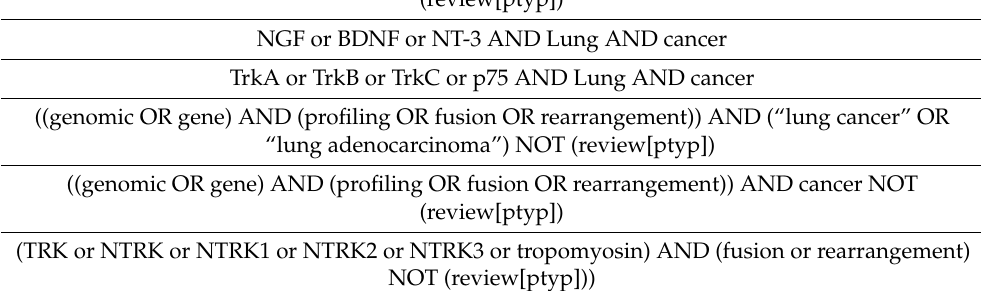
Table 1. Search strategy